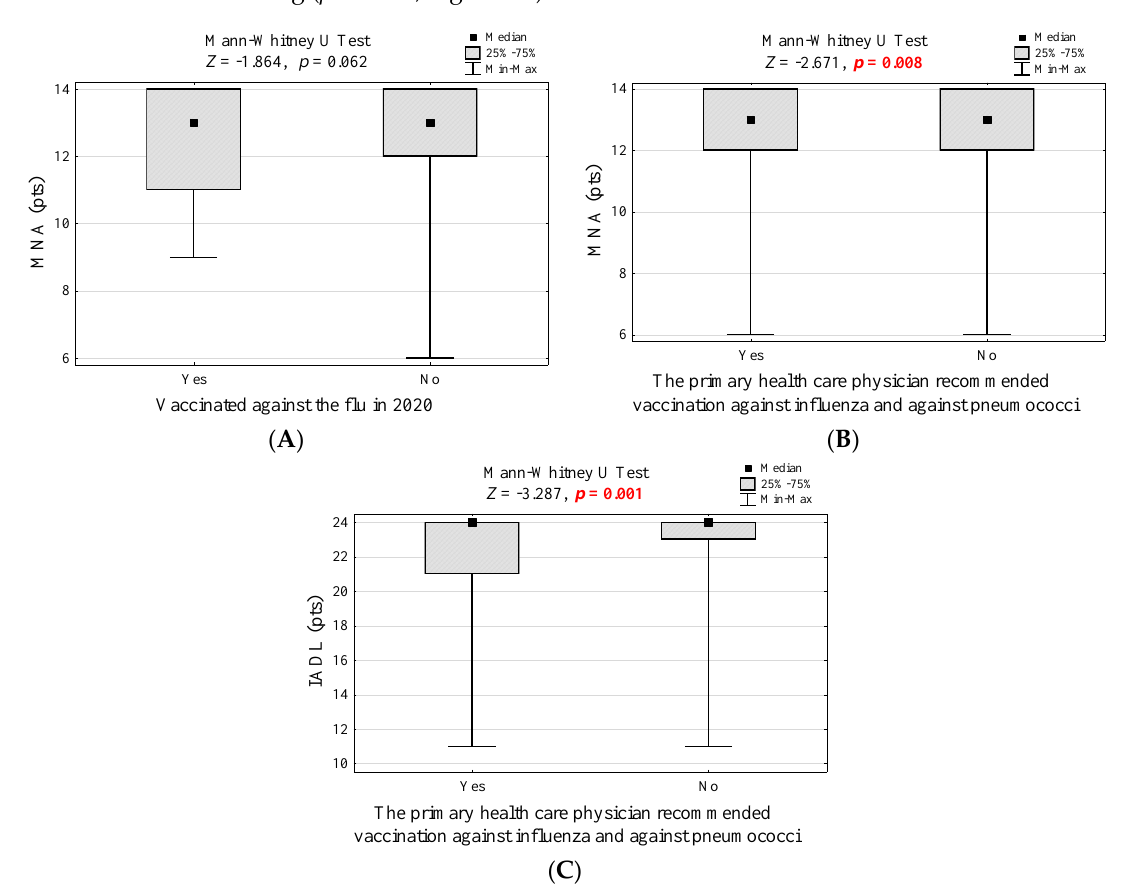
Figure 2. ( A ) Nutritional status in groups of people that differed in influenza vaccination in 2020 and the result of the significance test; ( B ) Assessment of the nutritional status in groups of people who were recommended or not by a primary healthcare physician for influenza and pneumococcal vaccination, and the test of significance; ( C ) Assessment of complex activities of everyday life in groups of people who were recommended or not by a primary healthcare physician to vaccinate against influenza and pneumococci, and the result of the significance test.